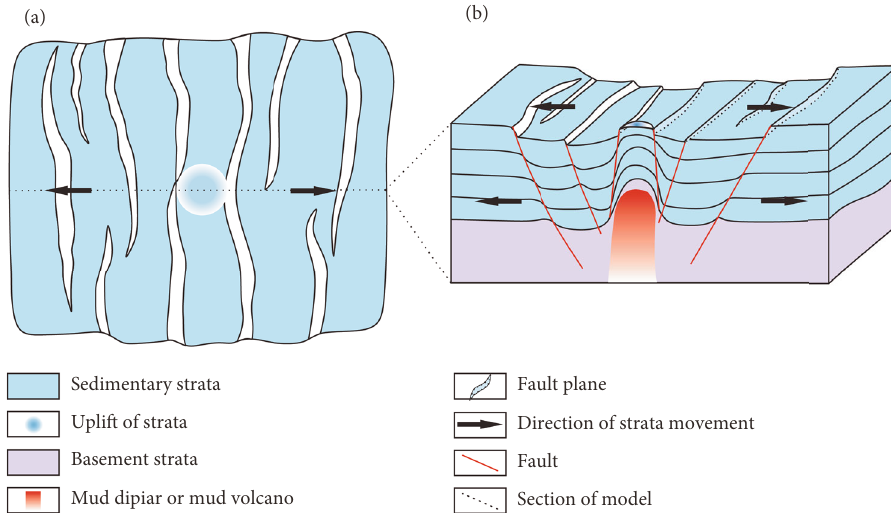
Figure 12: Development mechanism model of mud diapirs/mud volcanoes under extensional background. (a) The top view of the strata after the development of mud diapirs/mud volcanoes in the background of extension. It can be observed that a stratigraphic uplift is on the position where mud diapir or mud volcano develops. There are nearly symmetrical fault zones in the strata on both sides. (b) Three-dimensional map of the development mechanism of mud diapirs/mud volcanoes under the background of extension. The faults developed on both sides of mud diapir/mud volcano are symmetrically distributed and form grabens. In the mud diapir/mud volcano development position, the strata are obviously pulled up, and the top strata are uplifted.